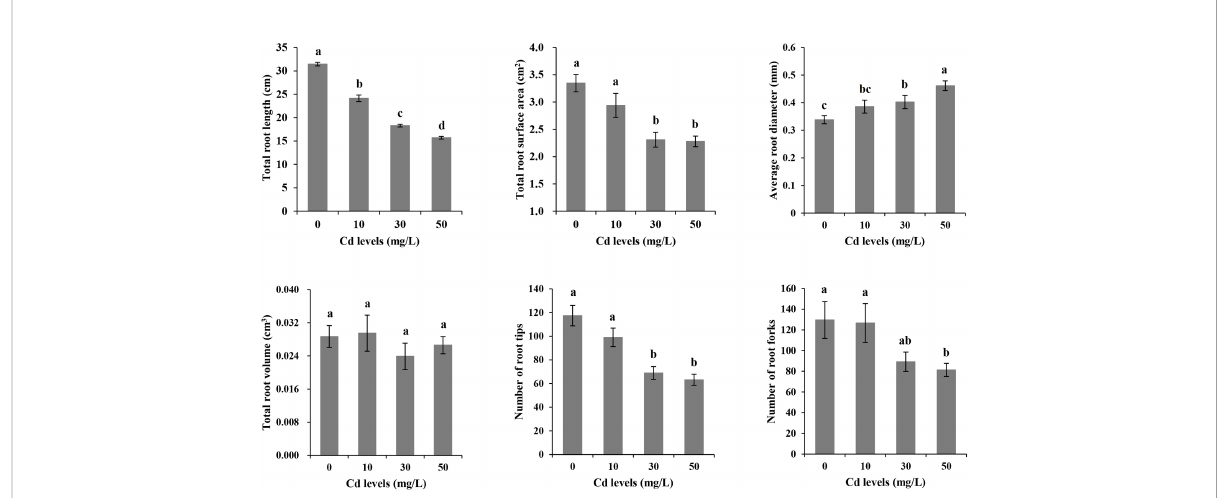
FIGURE 2 The morphological characteristics of roots in Tartary buckwheat seedling under cadmium stresses. Different lowercase letters on the top of bars indicate signi fi cant differences between treatments according to Duncan t -test ( p -value <